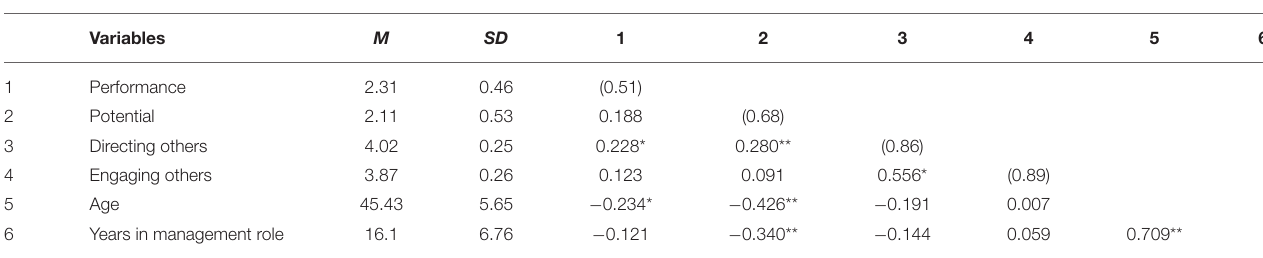
TABLE 2 | Descriptive statistics and correlations. Means, standard deviations, reliabilities, and intercorrelations among study variables